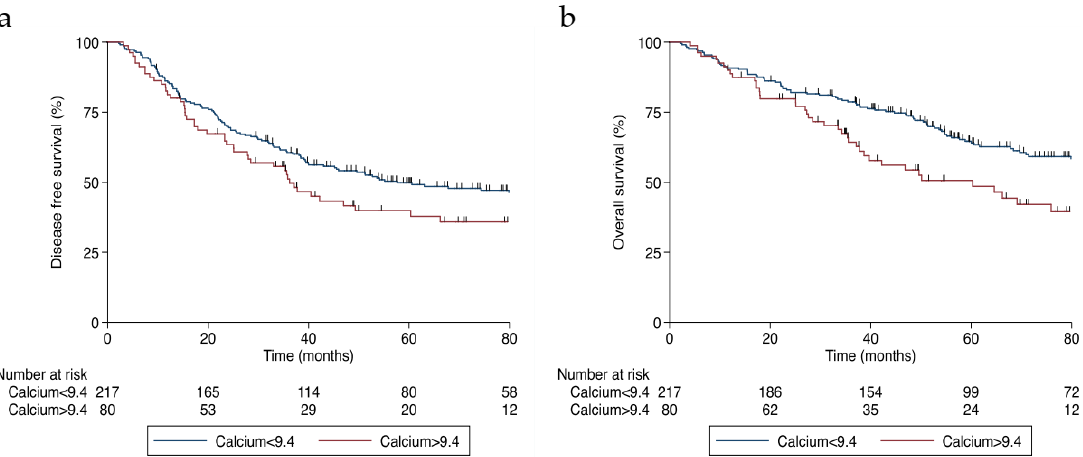
Figure 3. Survival curves of patients with stage I–III colorectal cancer divided by corrected calcium levels (in mg/dL): ( a ) disease-free survival and ( b ) overall survival .